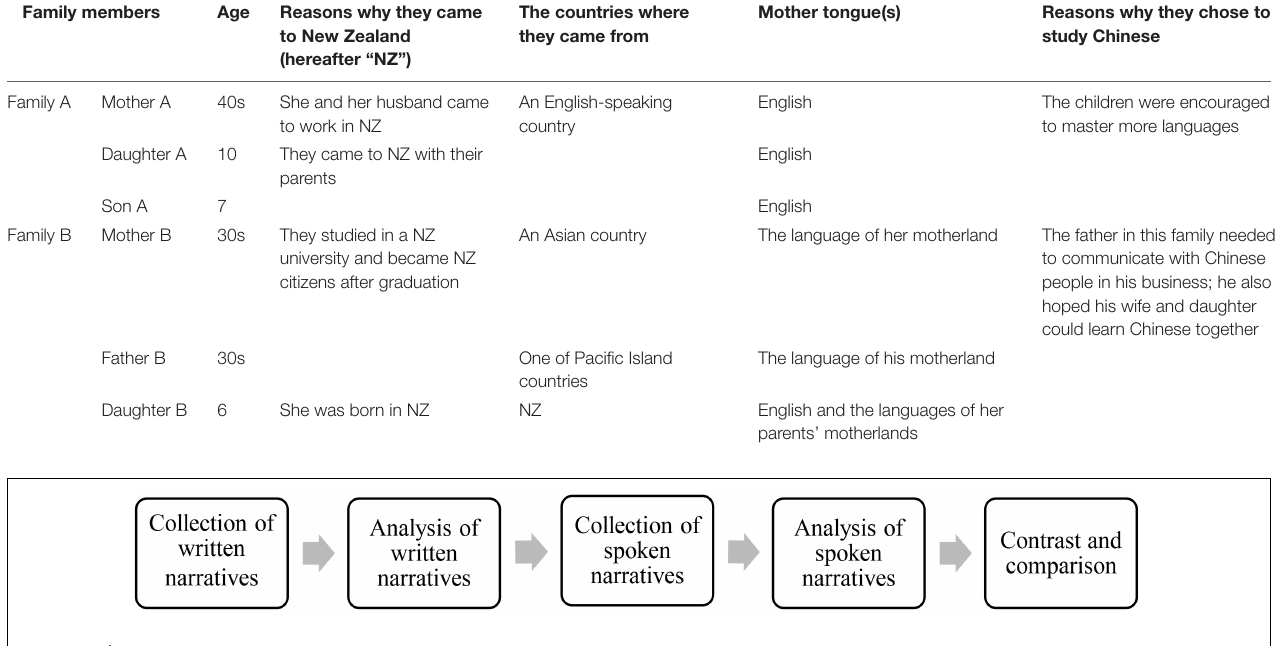
FIGURE 1 | The research